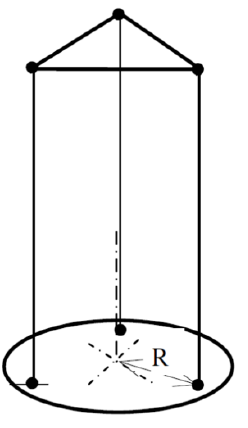
Figure 4. Trifilar Figure 4. Trifilar pendulum.